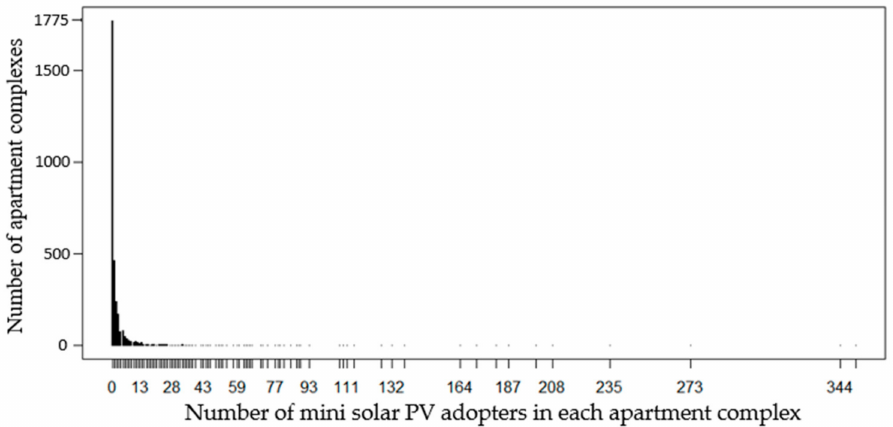
Figure 4. Distribution of mini-solar PVs in